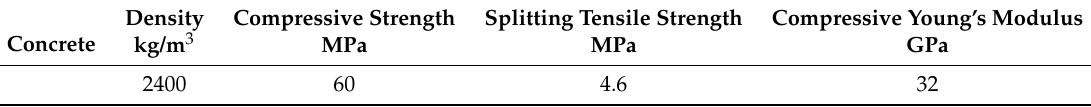
Table 1. Quasi-static mechanical properties of